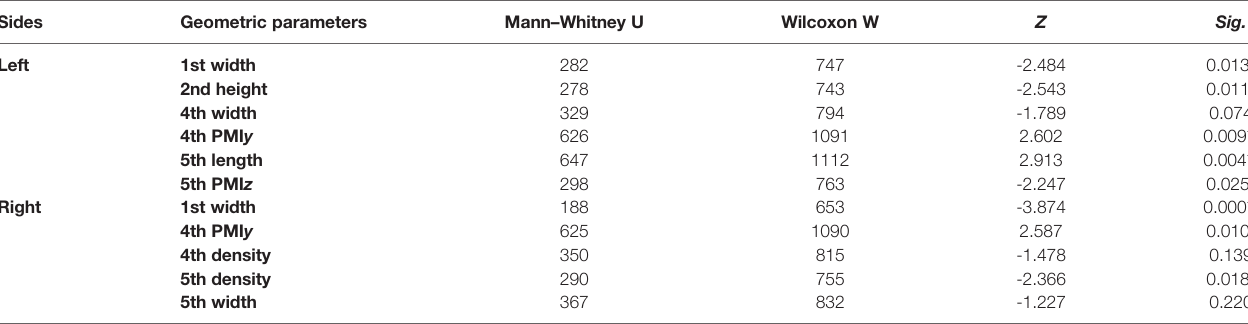
TABLE 7 | Mann-Whitney U test results of variables of metatarsal bone in vivo based on its PAI between sexes. Sides Geometric